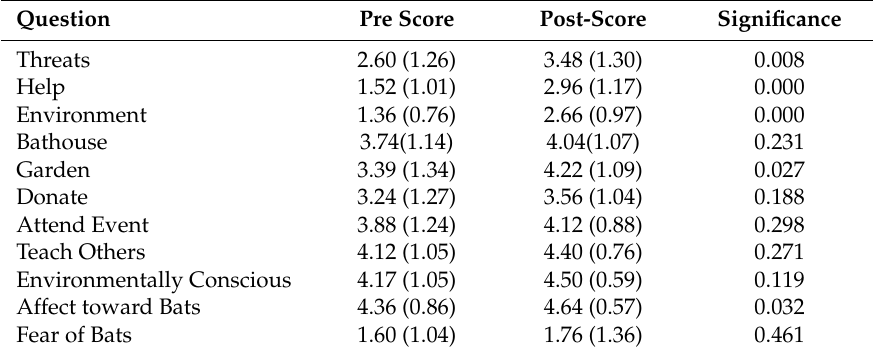
Table 1. Mean survey responses, with standard deviations in parentheses, pre and